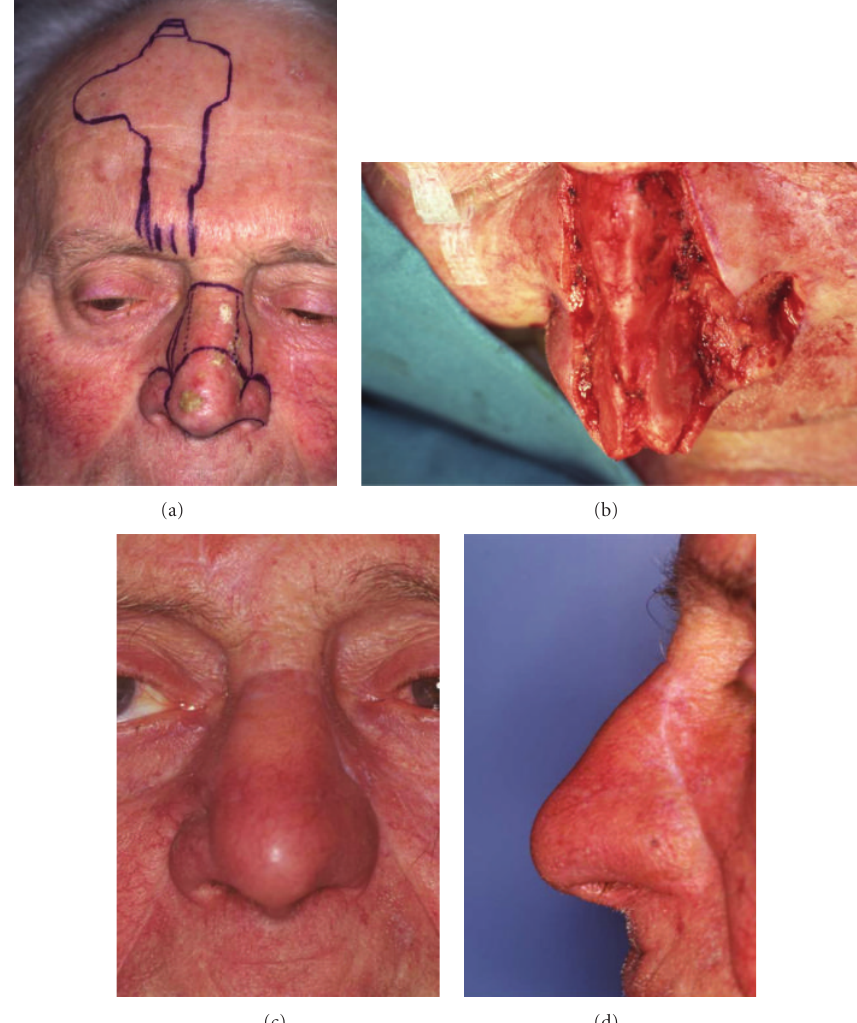
Figure 4: (a) Multifocal nasal skin cancer: flap design. (b)Skin defect after tumour resection. (c) Nasal appearance one year after surgery: frontal view. (d) Nasal appearance one year after surgery: lateral